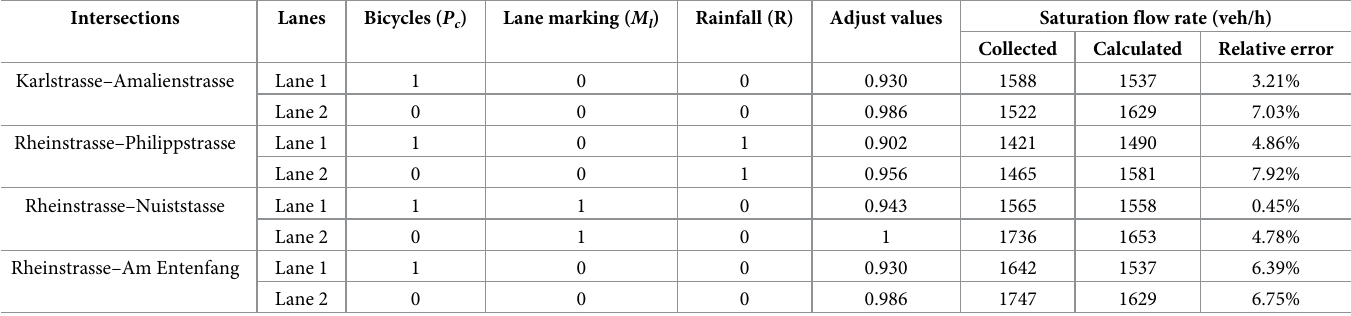
Table 6. Calculated Saturation flow